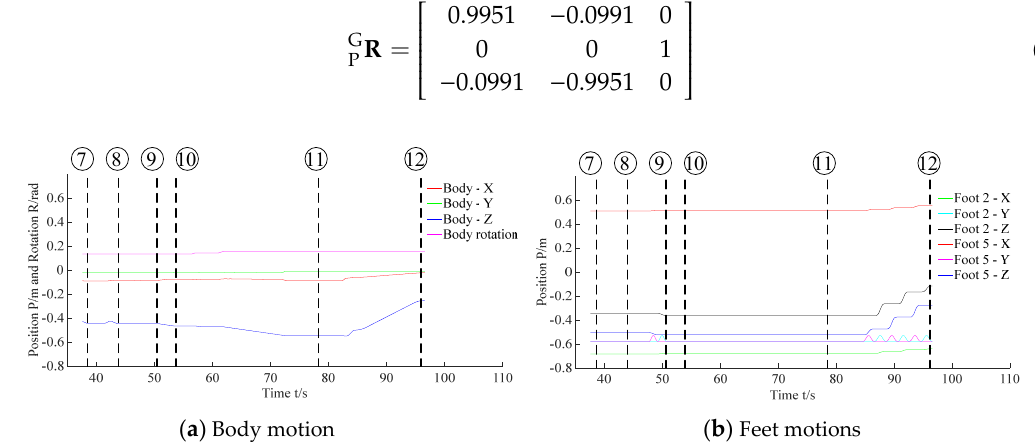
Figure 16. Motions of the body and feet in the processes of F/T locating and insertion assembly.